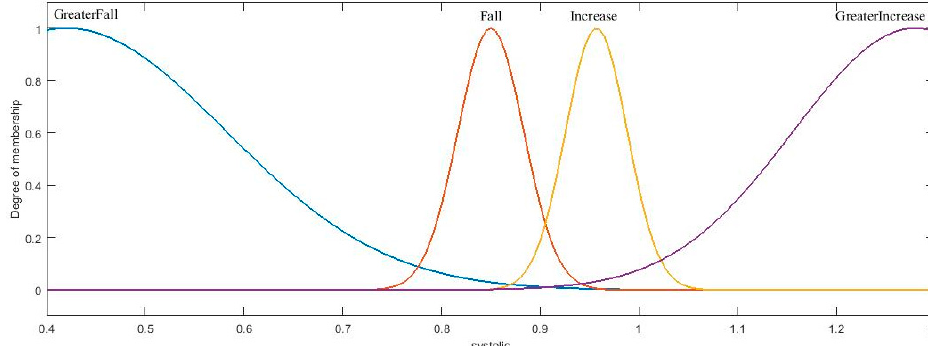
Figure 15. Systolic quotient input.